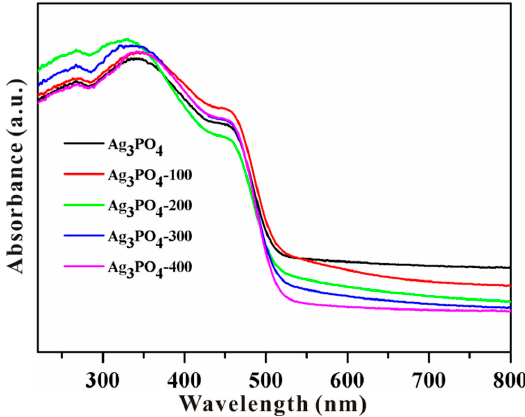
Figure 9. UV-Vis DRS of pristine Ag 3 PO 4 and Ag 3 PO 4 -T (T = 100, 200, 300 and 400).